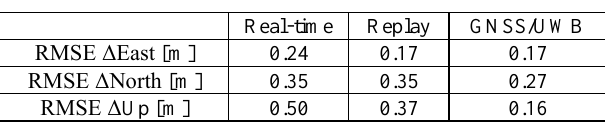
Table 8. Accuracy of the